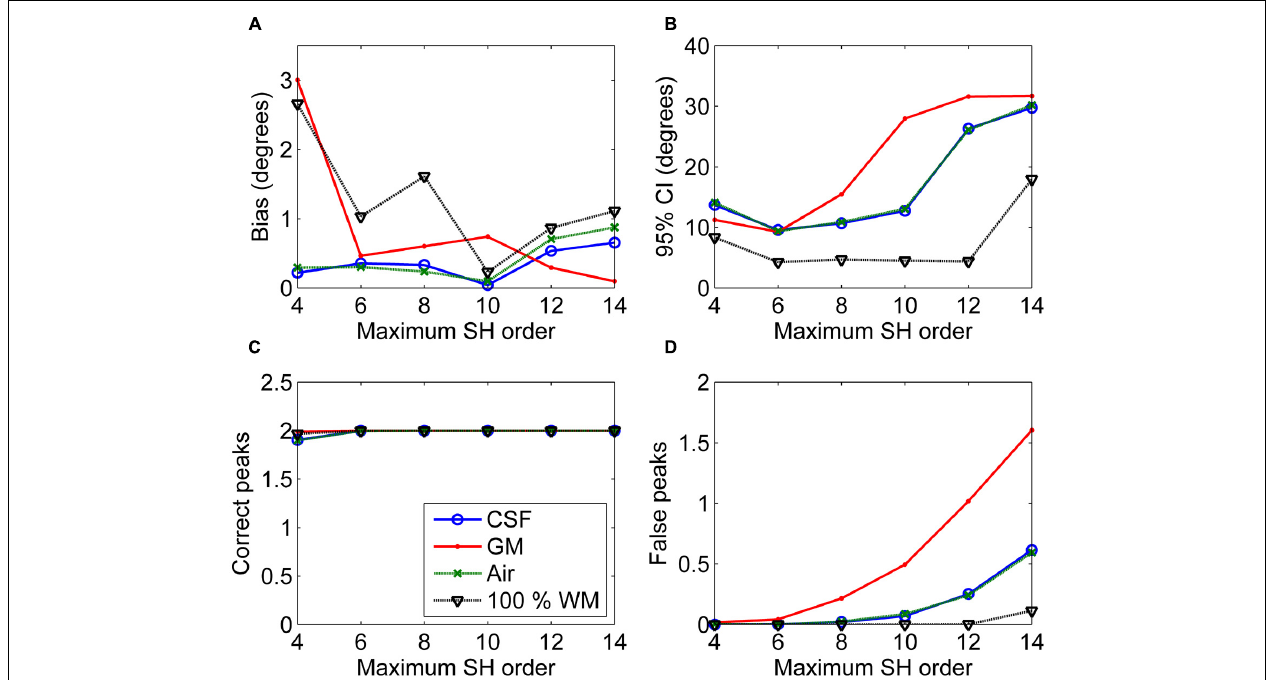
FIGURE 3 |The effect of varying maximum SH orders with 50% non-WM partial volume (CSF, GM, and air) to bias (A), 95% confidence interval (CI) (B), and the number of correct (C) and false peaks (D) estimated with CSD (with diffusion weighting 3000 s/mm 2 , angle 70 ◦ , and SNR 30). For comparison, 100%WM measures are provided.